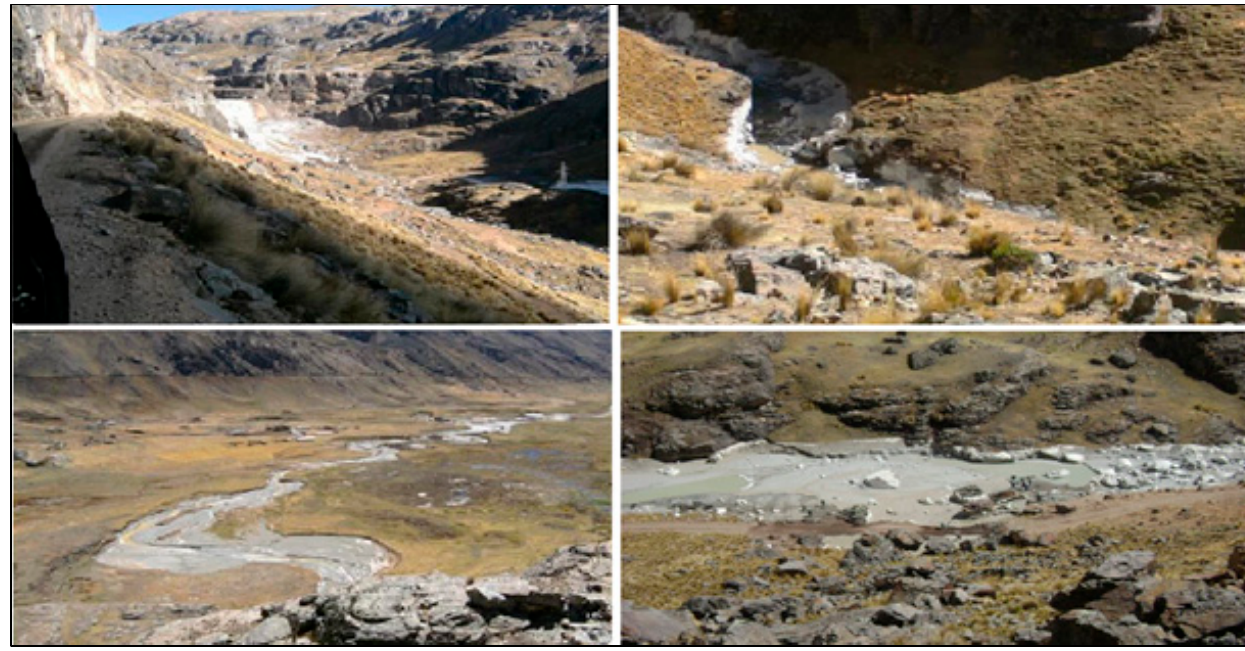
Figure 11. Effects of the flow of tailings spilled in the Escalera and Huachocolpa rivers [45,46].